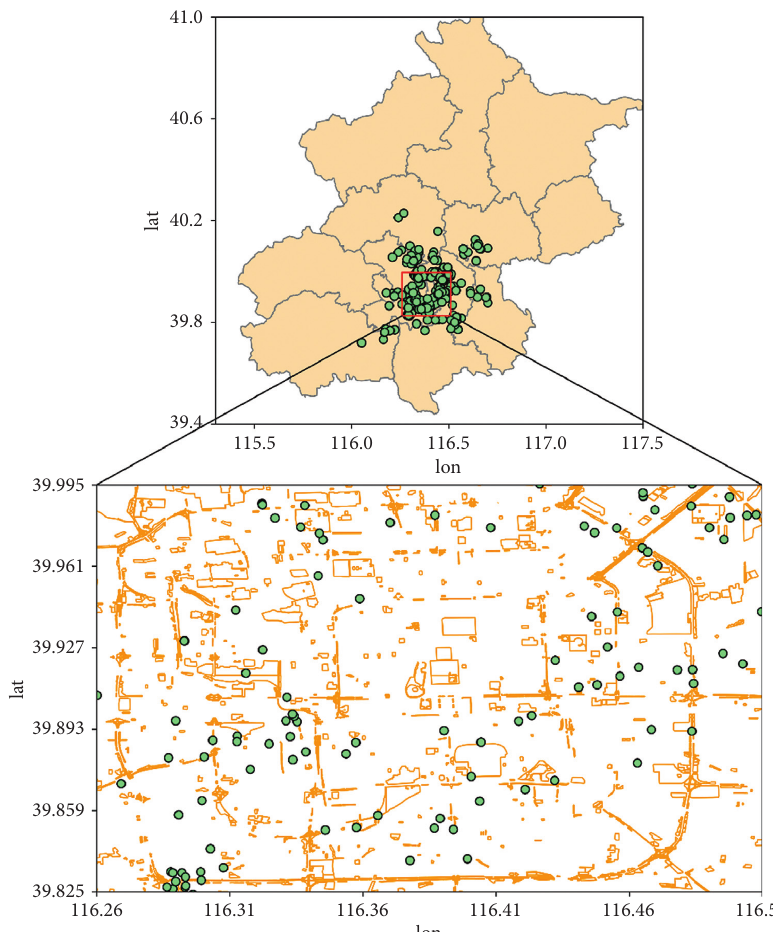
Figure 2: Spatial distribution of the existing stations.